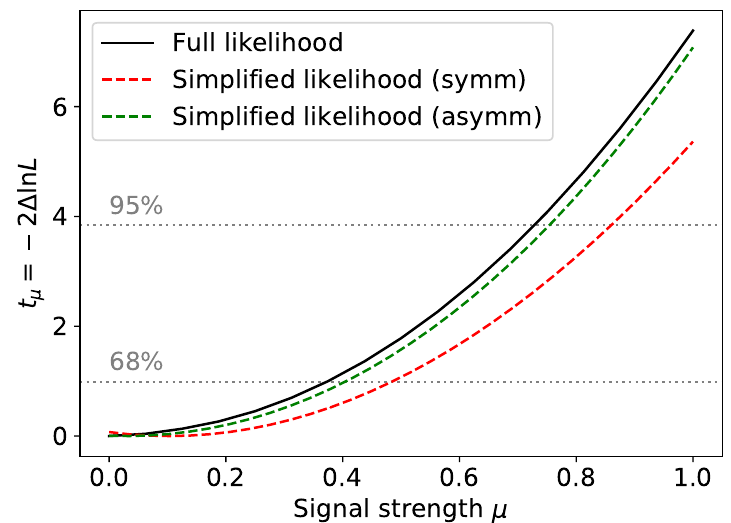
Figure 5 . Value of t as a function of (cid:22) for the pseudo-search assuming the experimental likelihood (cid:22) (black solid line) and simpli(cid:12)ed likelihood retaining (green dashed line) or not (red dashed line) the contribution from the quadratic term. The horizontal lines drawn at t = 1 and 3 : 86 represent the (cid:22) values for which the 68% and 95% CL exclusions can be determined, assuming certain asymptotic properties of the distribution of t . (cid:22)